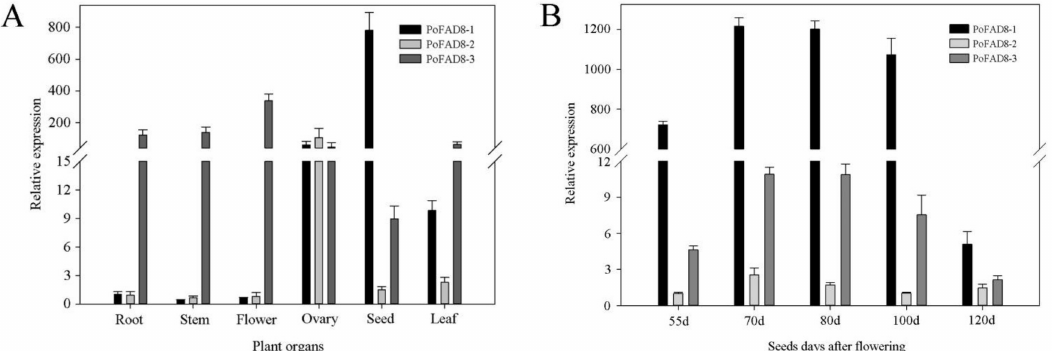
Figure 5. PoFAD8-1 , PoFAD8-2 , and PoFAD8-3 genes expression were measured during seed development and different organs in the Paeonia ostii T. Hong & J. X. Zhang. ( A ) Tissue specific expression of PoFAD8-1 , PoFAD8-2 , and PoFAD8-3 . ( B ) PoFAD8-1 , PoFAD8-2 , and PoFAD8-3 expression during Paeonia ostii seed development. The error bar represents the standard deviation of three replicates. The tree peony UBQ was used as an internal